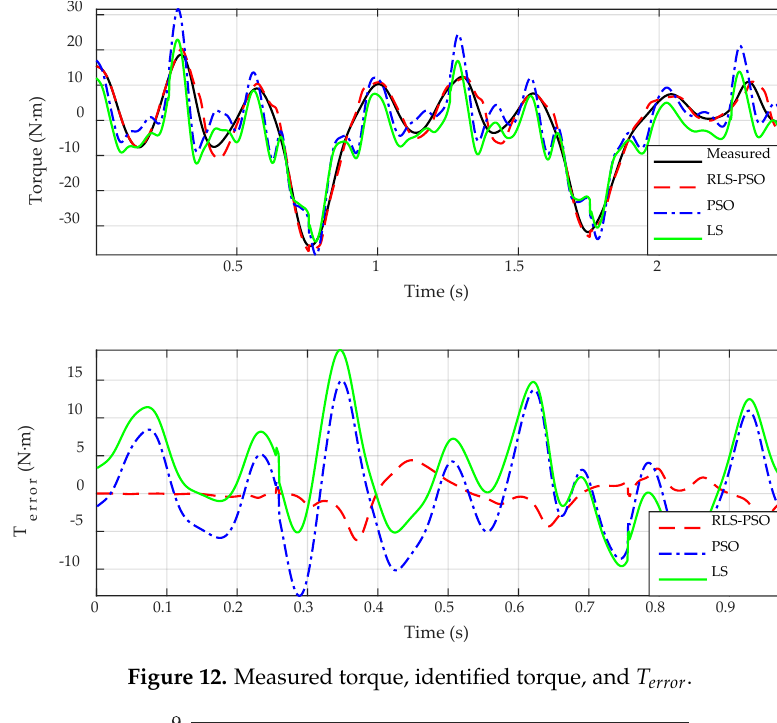
Figure 12. Measured torque, identified torque, and T error .